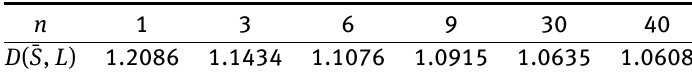
Table 1: The values of D (¯ S ( µ ), L ( µ )) with m = 2 and different n . n 1 3